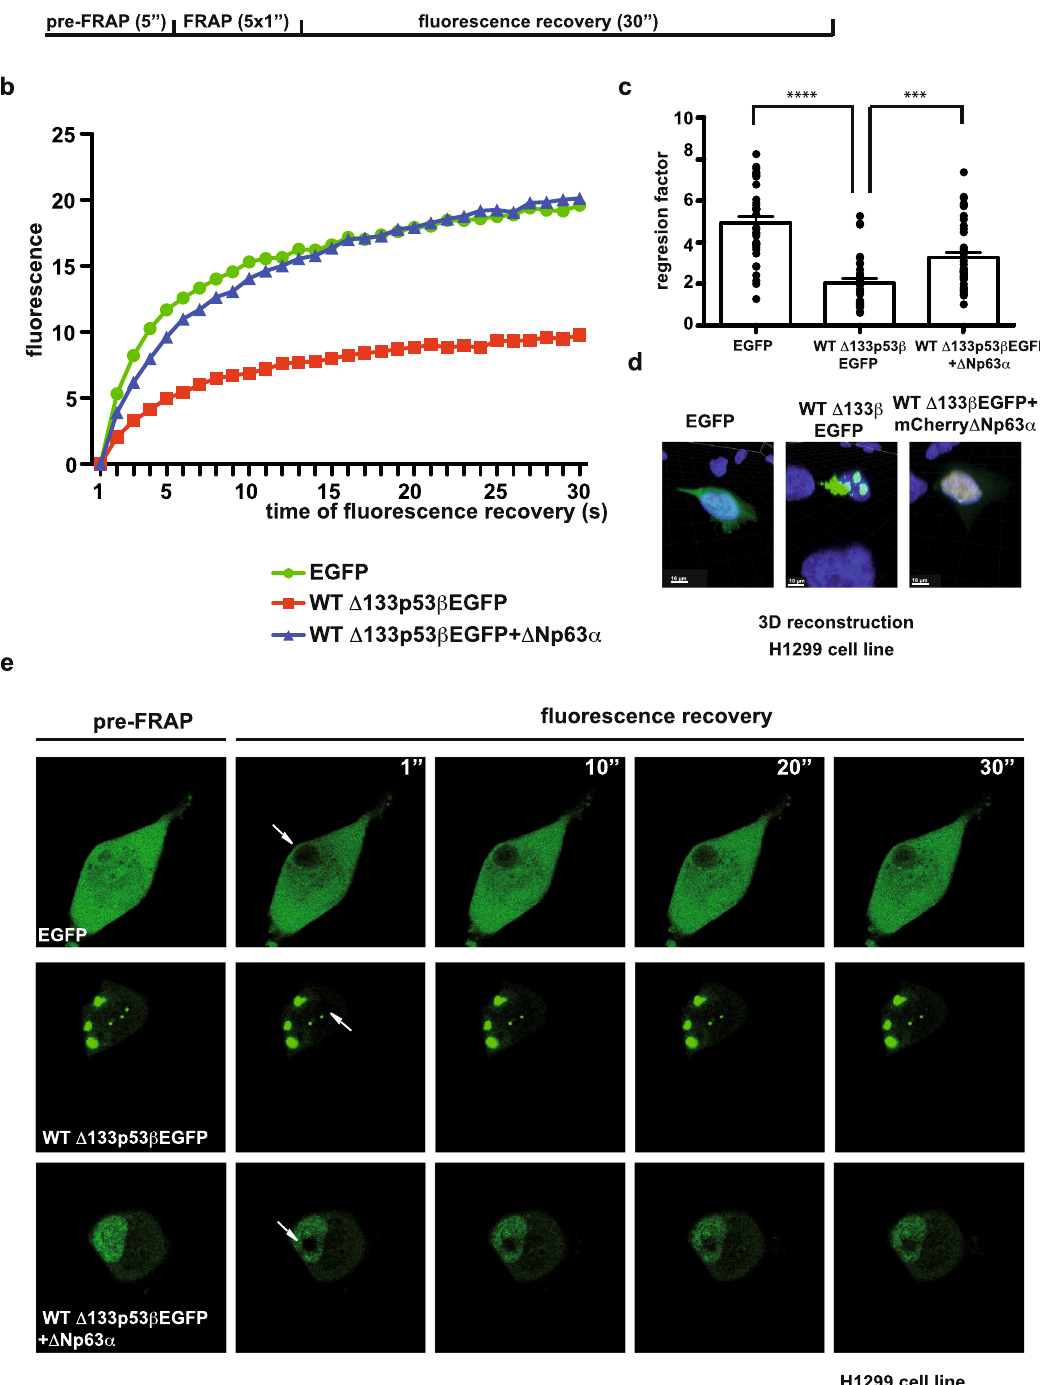
Fig. 6 Δ 133p53 β molecules dynamics is highly increased in the presence of the Δ Np63 α protein partner. a Flow chart of the FRAP experiment. b Graphical representation of the normalised fl uorescence recovery curves depleted for background fl uorescence pooled from three independent experiments. SEM not shown for clarity. c Quanti fi cation of the regression factor with R 2 with no less of 0.95 pooled from three independent experiments. Values plotted are the mean of ±SEM (error bars). Statistical analysis was performed using non-parametric Mann – Whitney t test with the Prism software (GraphPad). The fi rst p value is <0.0001 and second is 0.0003. d Immuno fl uorescent analysis of EGFP, WT Δ 133p53 β EGFP and co-expressed WT Δ 133p53 β EGFP and mCherry Δ Np63 α in H1299 cell line upon 3D reconstruction of the confocal Z-stacks. Green: EGFP ( Δ 133p53 β ), Red: mCherry ( Δ Np63 α ), blue: Hoechst. Scale bar 10 μ m. Representative images of one out of three independent experiments are shown. e Time-lapse images from Supplementary movies 10 – 12 from FRAP experiments performed on EGFP, WT Δ 133p53 β EGFP and co expressed WT Δ 133p53 β EGFP and mCherry Δ Np63 α in H1299 cell line. The arrows indicate FRAP zone. n = 3 for FRAP experiments. Source data are provided as a Source Data fi